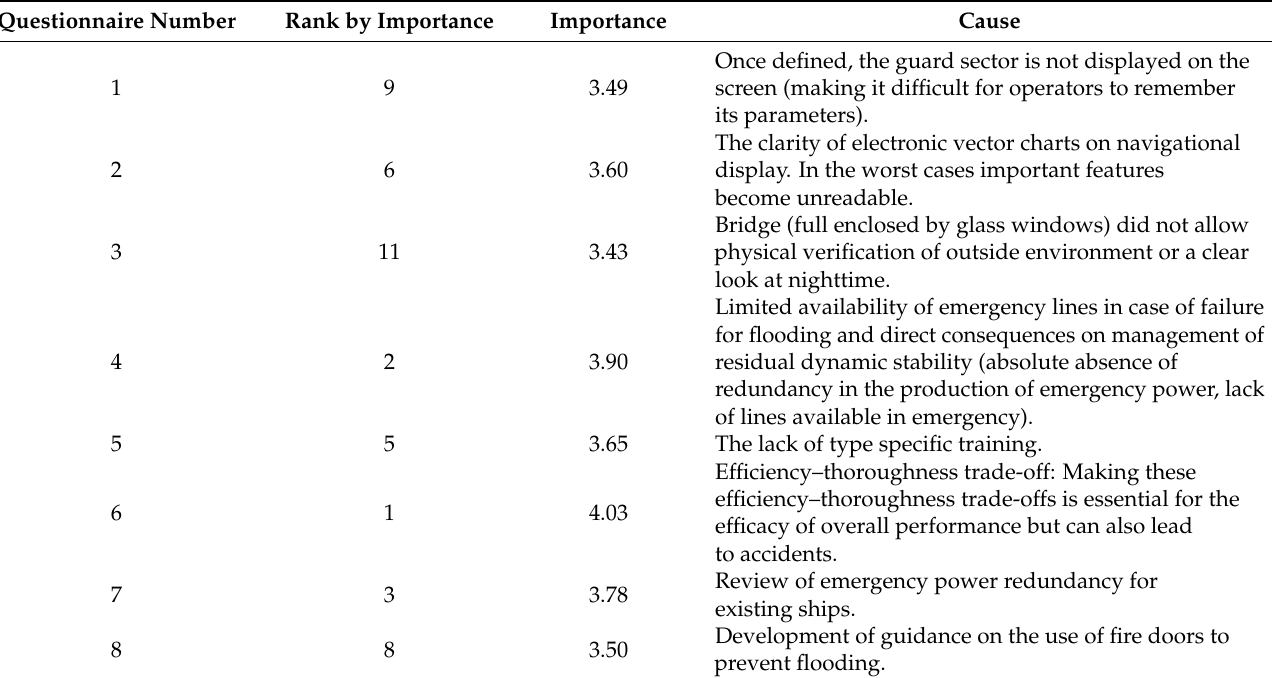
Table 7. Causes of the accident from the accident report, articles, and the IMO long-term action plan that were not addressed after the Costa Concordia